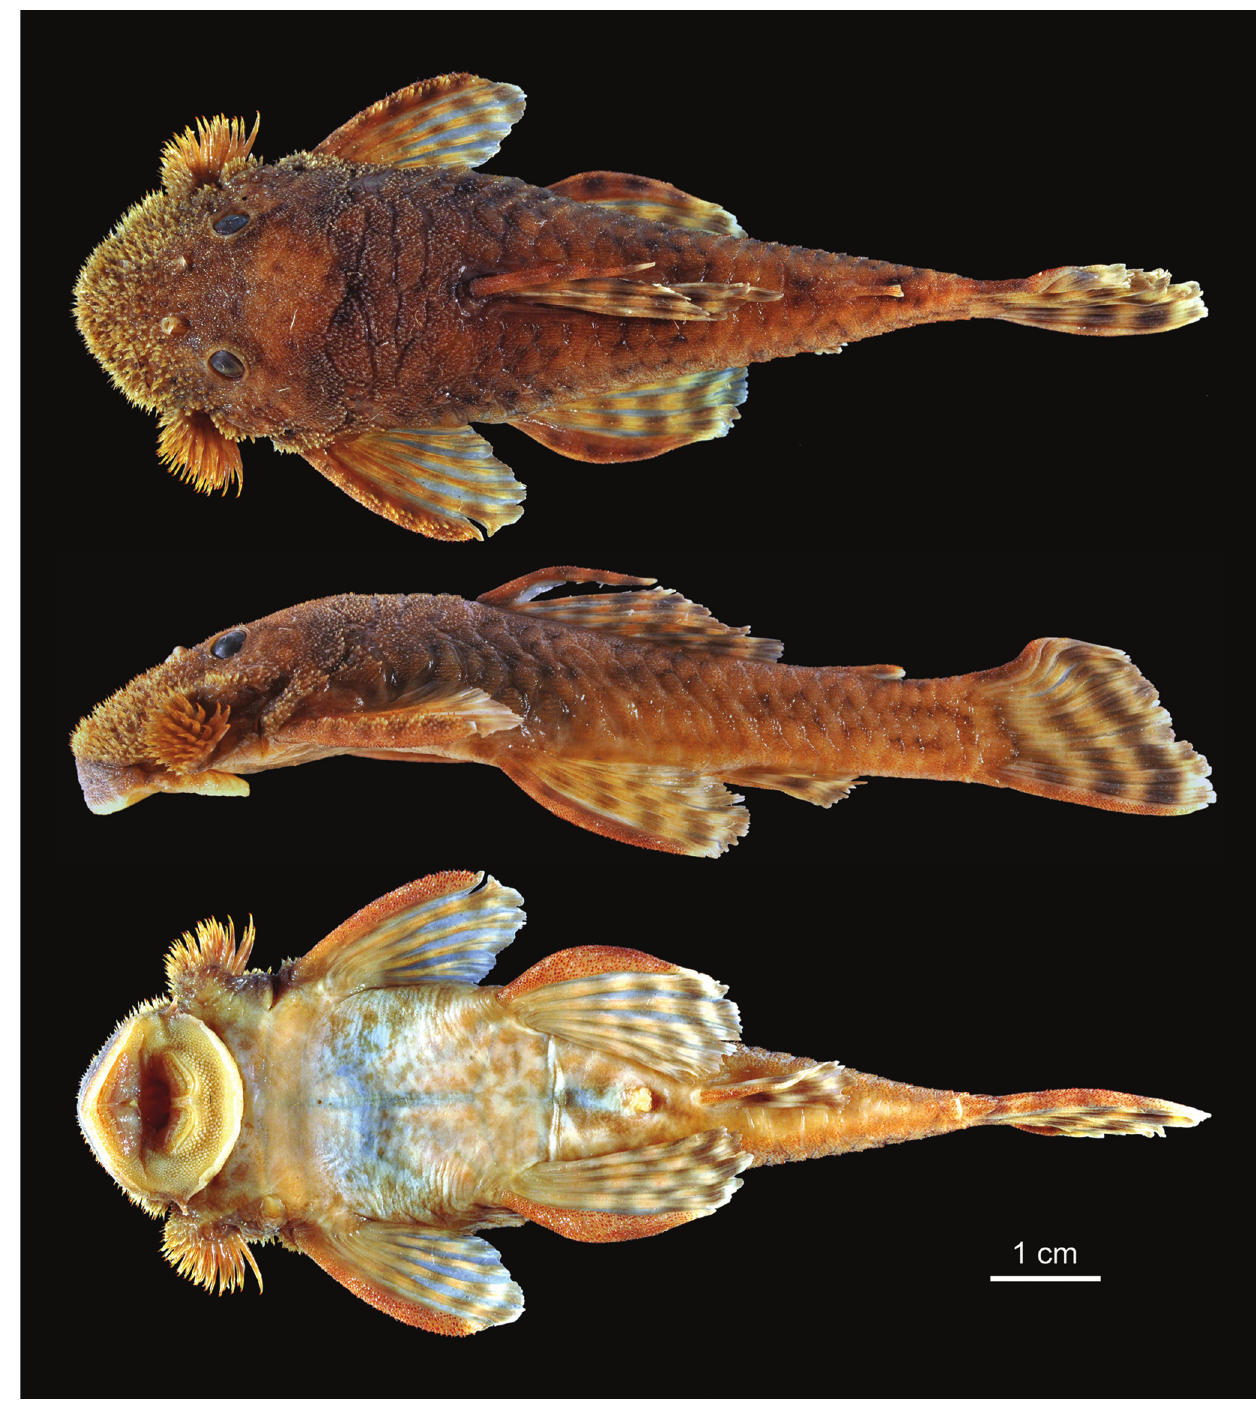
Fig. 2. Dorsal, lateral, and ventral views of Neblinichthys peniculatus , holotype, male, MBUCV V-35680, 78.8 mm SL, Venezuela, Bolivar, río Paragua drainage, río Carapo at first rapids along right